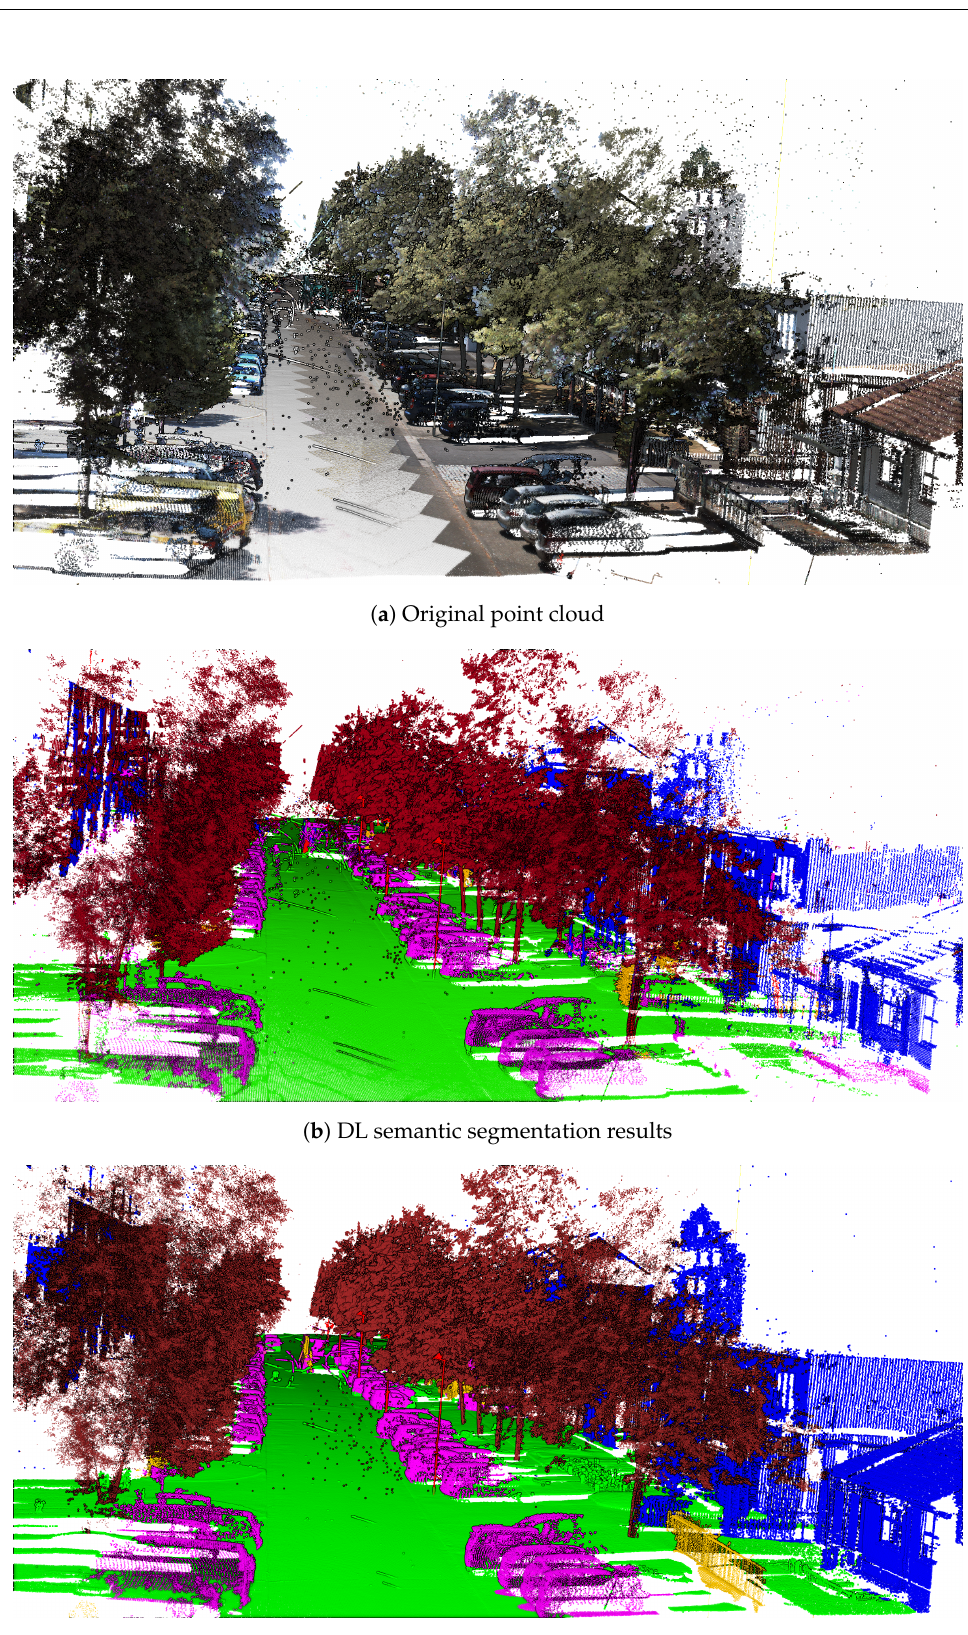
Figure 7. Point clouds used for the comparison. The comparison between the KB approach and the DL approach is presented in Tables 1 and 2 for the classification of the six main classes in the